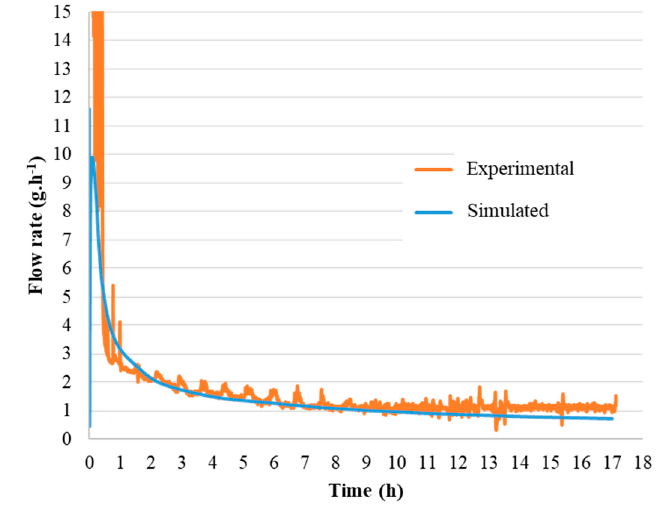
Figure 7. Comparison of the experimental and simulated injected mass flow rate of the suspension under a pressure of 3 × 10 6 Pa for a cake with a 10 mm diameter.